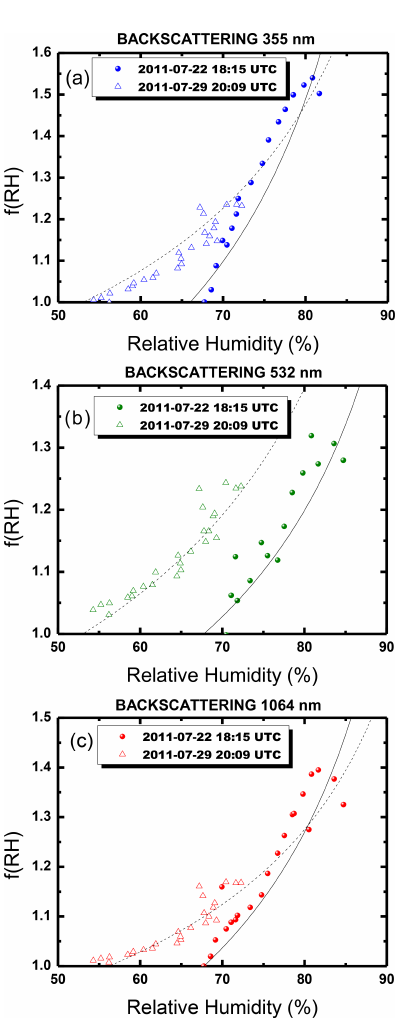
Figure 6. Humidograms of f (RH) versus relative humidity for the aerosol backscattering data obtained on 29 and 22 July 2011. Data are presented at the wavelengths of (a) 355nm, (b) 532nm and (c)